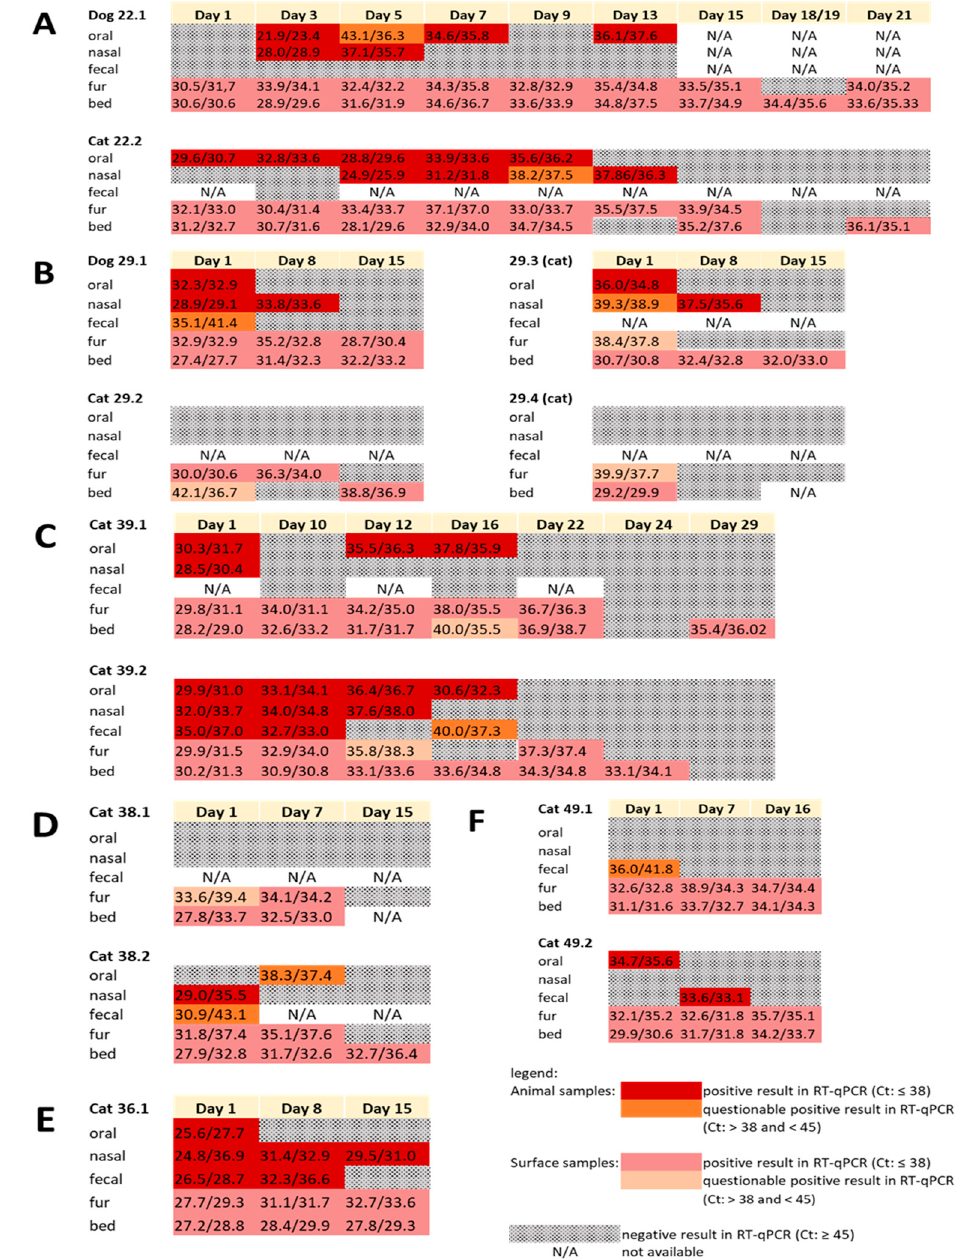
Figure 2. Real-time reverse transcriptase polymerase chain reaction (RT-qPCR) results of households USZ22 ( A ); USZ29 ( B ); USZ39 ( C ); USZ38 ( D ); USZ36 ( E ); and USZ49 ( F ). Results of the different tested (oral, nasal, fecal, fur, and bed) are